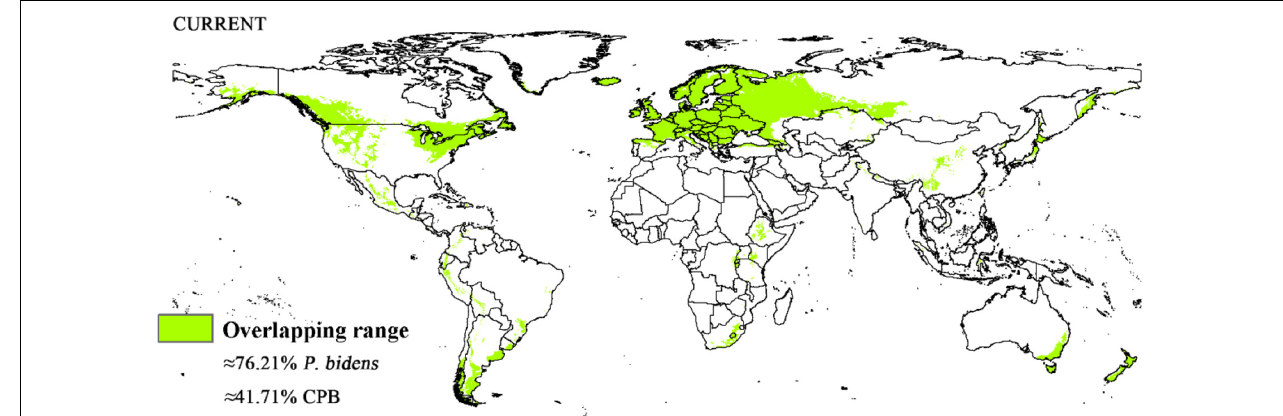
FIGURE 9 | Overlapping range in the suitable distribution area of CPB and P. bidens in current climate.